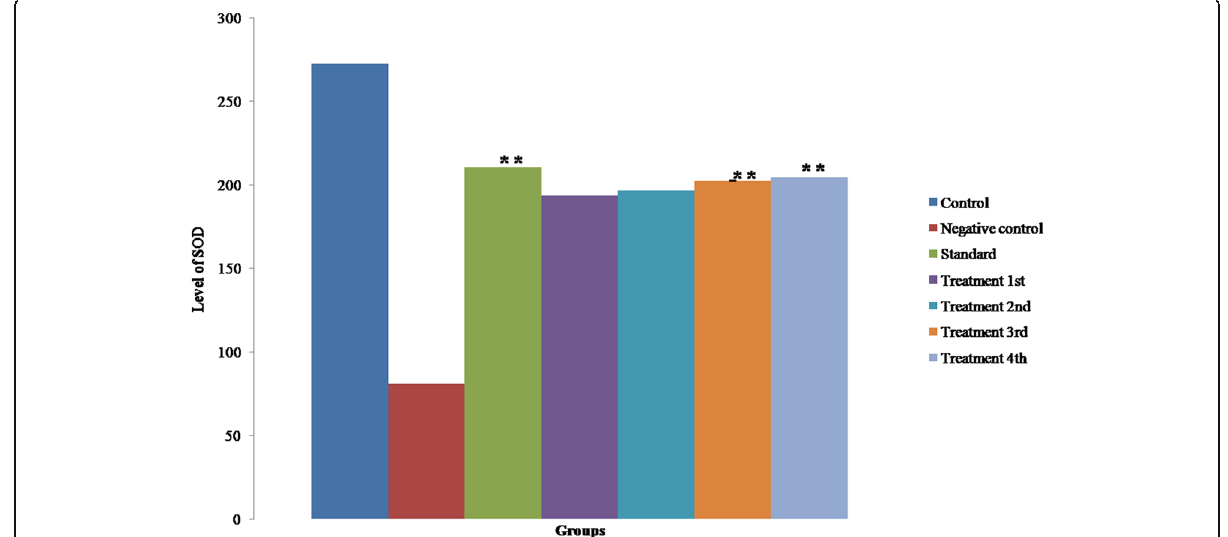
Fig. 9 Effects of PH extracts on SOD activity. Results are Mean ± S.E.M, n = 6 animals in each group. ANOVA, Dunnett ’ s test **p< 0.001 compared with arthritic control group